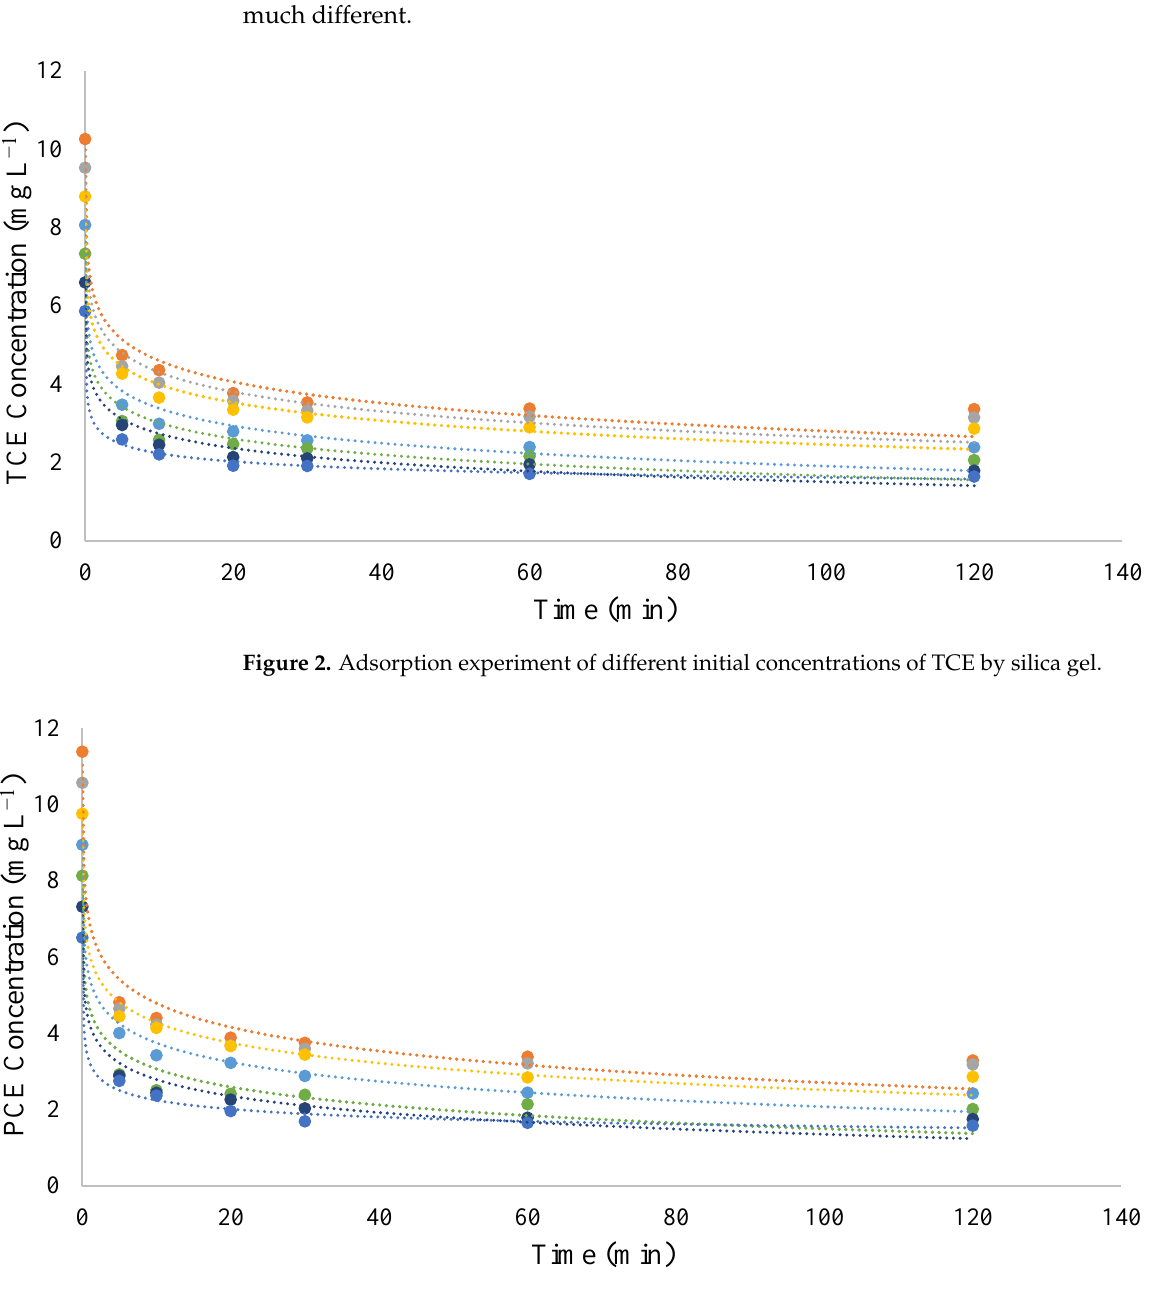
Figure 3. Adsorption experiment of different initial concentrations of PCE by silica gel.